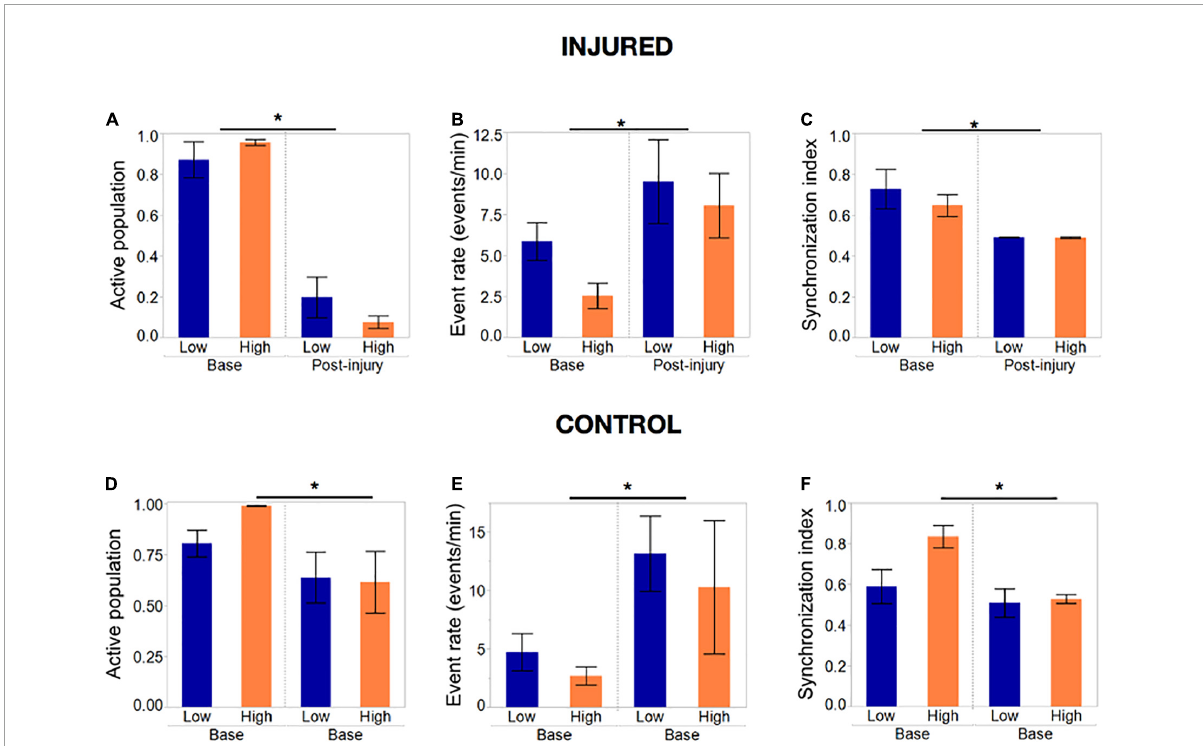
FIGURE8 Activity metrics in response to complete silencing of neuronal islands’ population. (A–C) Activity metrics at the end of the injury protocol; sets of five neurons were inactivated with the tap injury model until there no activity was detected by visual inspection. The active population was reduced significantly (but not 0) in both island groups, with neurons that remained active showing significantly higher rates of activity and a decreased synchronization index. Low- and high- density islands were not significantly different from each other post-injury. (D–F) Activity metrics in control dishes that underwent the same illumination protocol, but no tap injury, revealed a significant decrease in the fraction of the population active, coupled with an increase in the activity rate and decrease in synchronization. Significance level was set at * p <